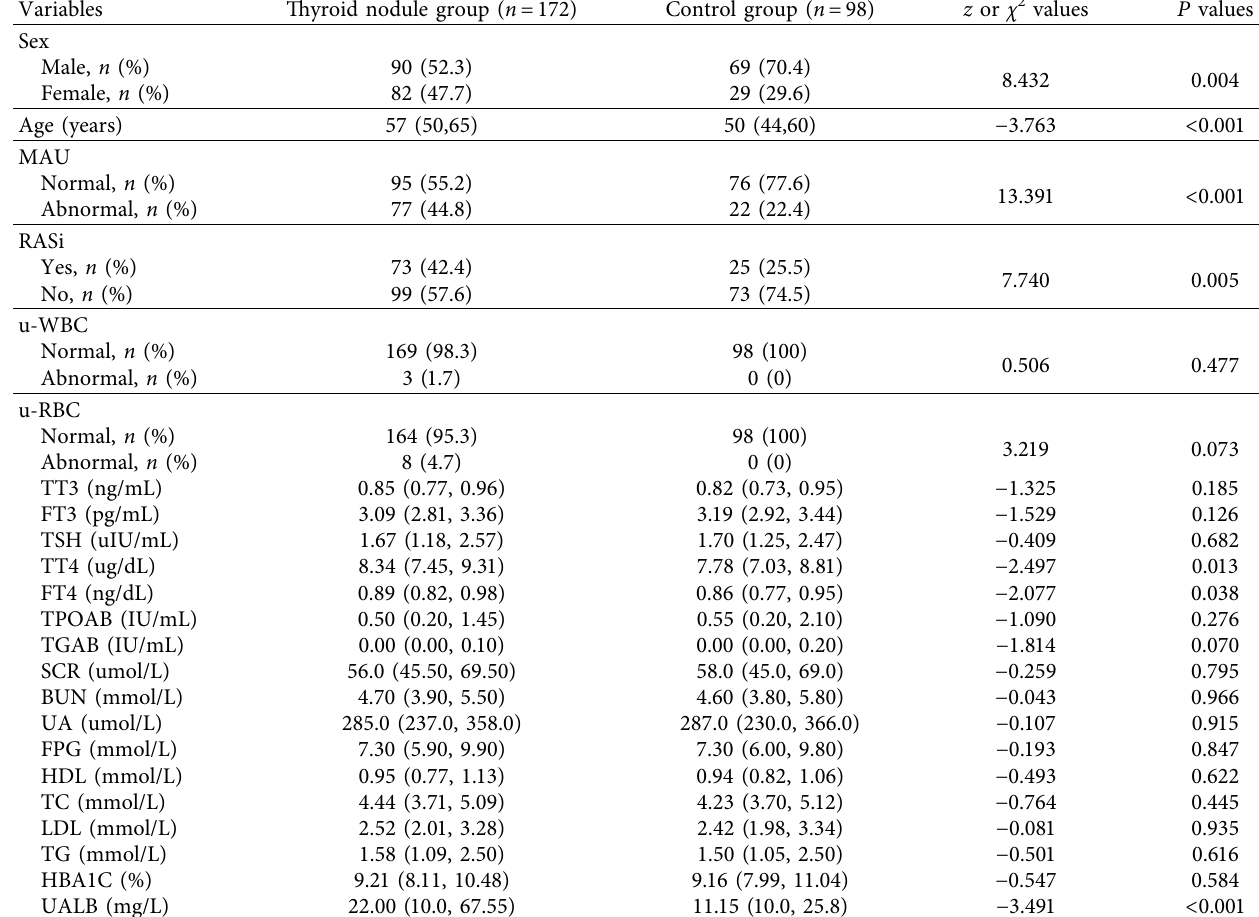
Table 1: Clinical and laboratory characteristics of study subjects.